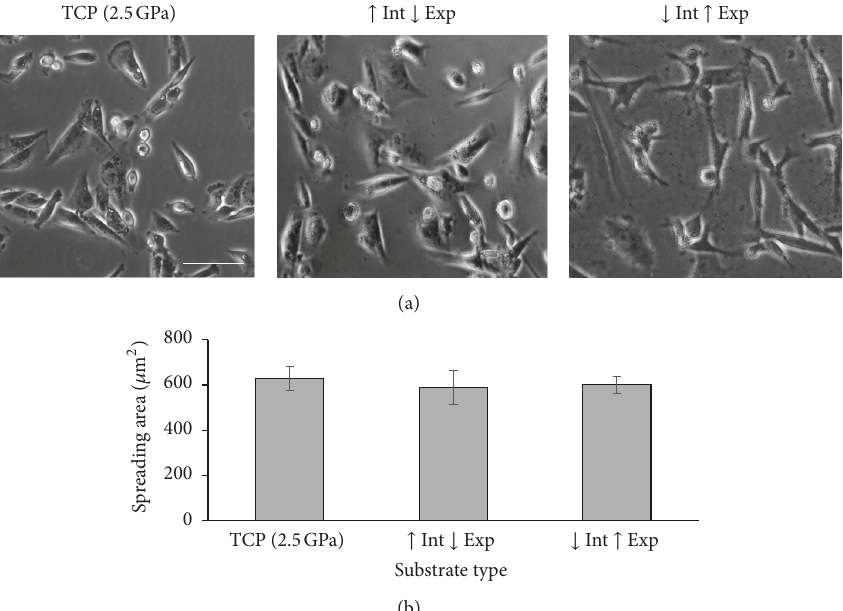
Figure 6: Cell morphology after 24 h of culture on collagen-coated UV-polymerized A12-B.25 PAA hydrogels. (a) Phase contrast images of MDA-MB-231 cells seeded onto PAA gels of equal dose, but with different exposure times and UV intensity. The “ ↑ Int ↓ Exp” condition had an intensity of 67 mW/cm 2 and exposure time of 119s. The “ ↓ Int ↑ Exp” condition had an intensity of 15mW/cm 2 and exposure time of 524 s. (b) No significant differences were found in the spreading area of MDA-MB-231 cells seeded onto PAA gels of equal dose (8mJ/cm 2 ), but with different exposure time and UV intensity (same as in (a)). Scale bar represents 100 𝜇 m.